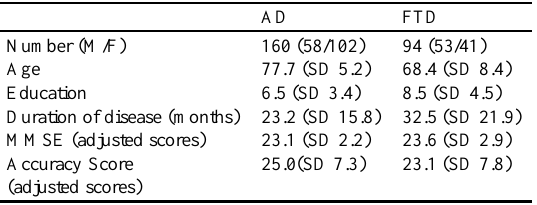
Table 3 Correlations between ToL AS score and tests examining global dete- rioration (MMSE) or executive functions in the two patients groups AD